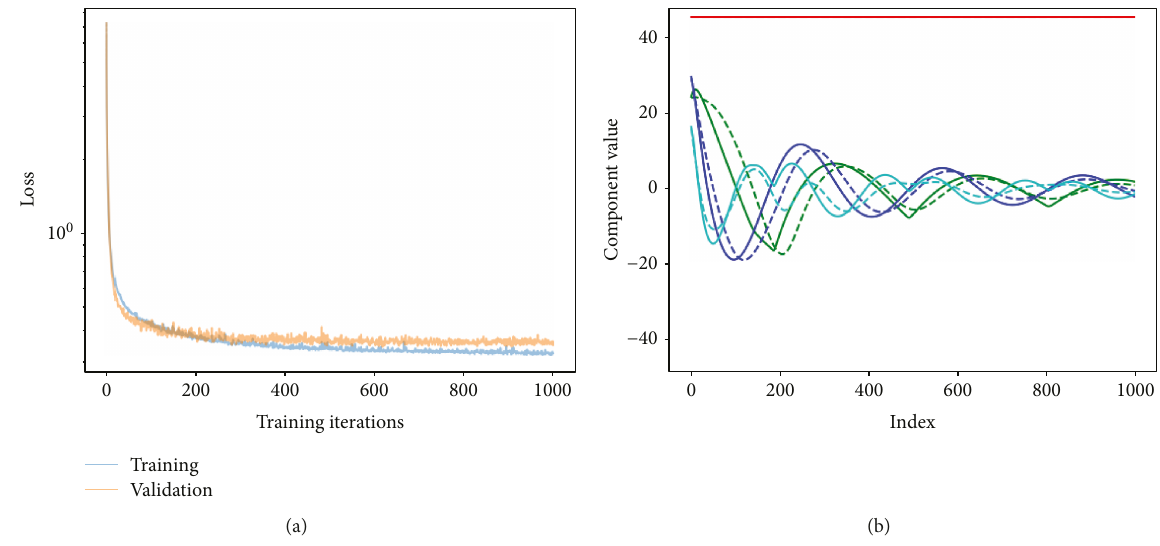
Figure 23: Result of the basic model for one-dimensional VBE turbulence case. (a) Learning curve. (b) A posteriori result with augmented training trajectories. Red: x